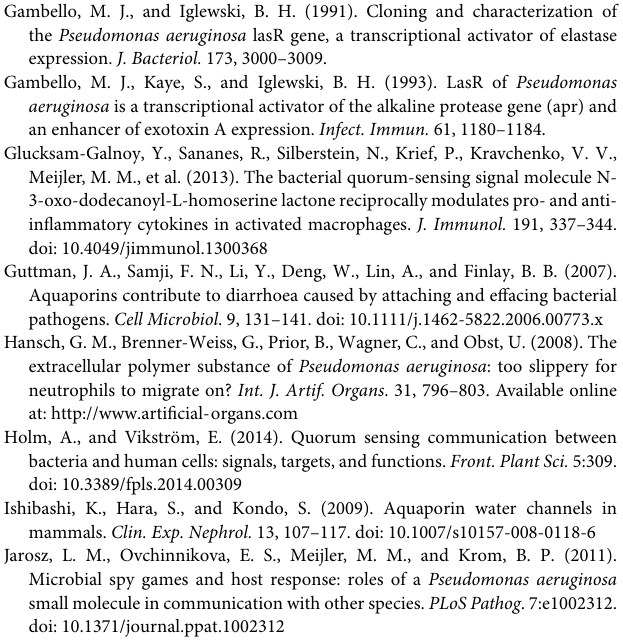
Figure S1 | The number of adherent and ingested wild type P. aeruginosa and its lasI-/rhlI- mutant by individual human macrophage. Macrophages were infected with GFP-labeled wild type P. aeruginosa or lasI-/rhlI- mutant, stained and analyzed by confocal microscopy as shown in Figure 1 . (A) Quantification of the number of ingested bacteria per macrophage. (B) Quantification of the number of bound and ingested bacteria (macrophage-associated bacteria) per individual macrophage. Shown are the mean ± SE of seven independent experiments performed at separate days from different blood donors (color coded and same donors as in Figures 1B,C ). The means ± SE are based on 100–200 cells for each condition per experiment Figure S2 | Super-resolution SIM imaging of AQP9 in macrophages infected with wild type P. aeruginosa and its QS mutant. Macrophages were infected with GFP-labeled (green) wild type P. aeruginosa, the lasI-/rhlI- mutant or non-infected (Control), for 1h. Cells were fixed and stained with antibodies against P. aeruginosa (blue), rabbit anti-AQP9 and Atto 647N goat anti-rabbit (red) and analyzed by SIM. Bacteria shown in green in these images were completely ingested. Bar 5 µ m. Table S1 | Changes in AQP mRNA levels for macrophages treated with wild type P. aeruginosa PAO1 or its lasI-/rhlI- mutant at MOI 1, 10 and 100 for 1h compared to levels for the control untreated